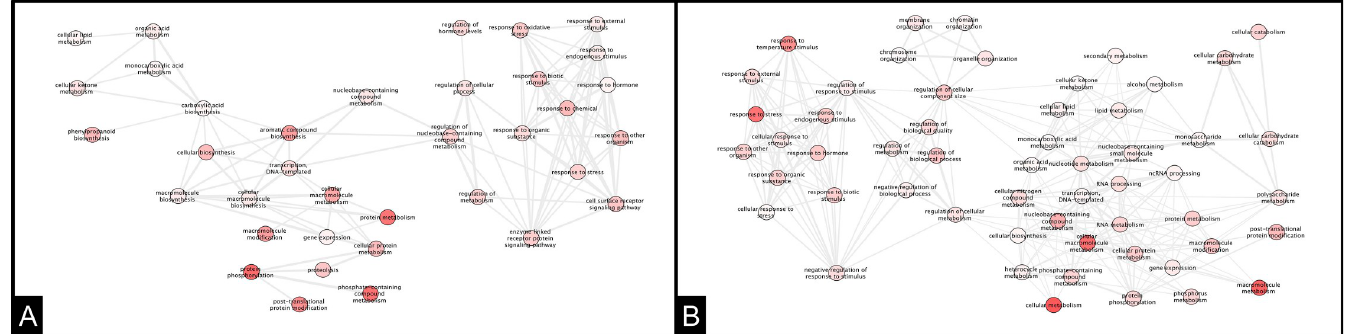
Fig 7. Interaction network of DEG in oil palm clones at 72 hpi of infection. A: Ortet 34 resistant B: Ortet 57 susceptible.